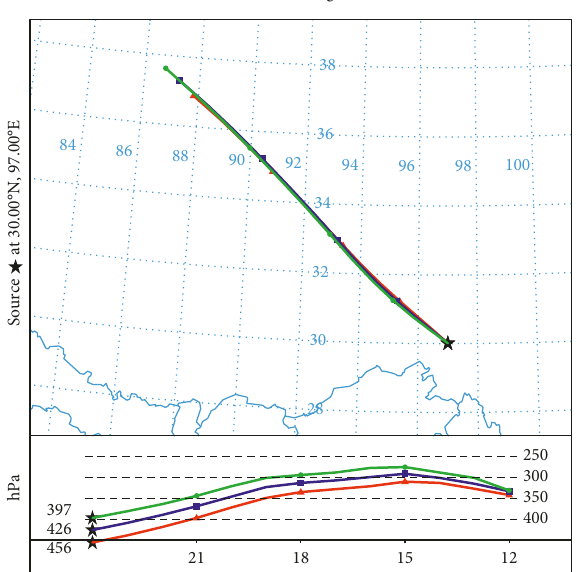
Figure 12: Backward trajectories at 2km (456 hPa), 2.5km (426 hPa), and 3km (397 hPa) levels above the ground. The top part of the panel shows the time evolution of trajectories in the hori- zontal region, and the bottom part of the panel shows the vertical variation of trajectories with time. 00:00 UTC 30 December 2018 is chosen as the beginning time, and the trajectories are 12 hours before this time. The departure point is located at 30 ° N, 97 °